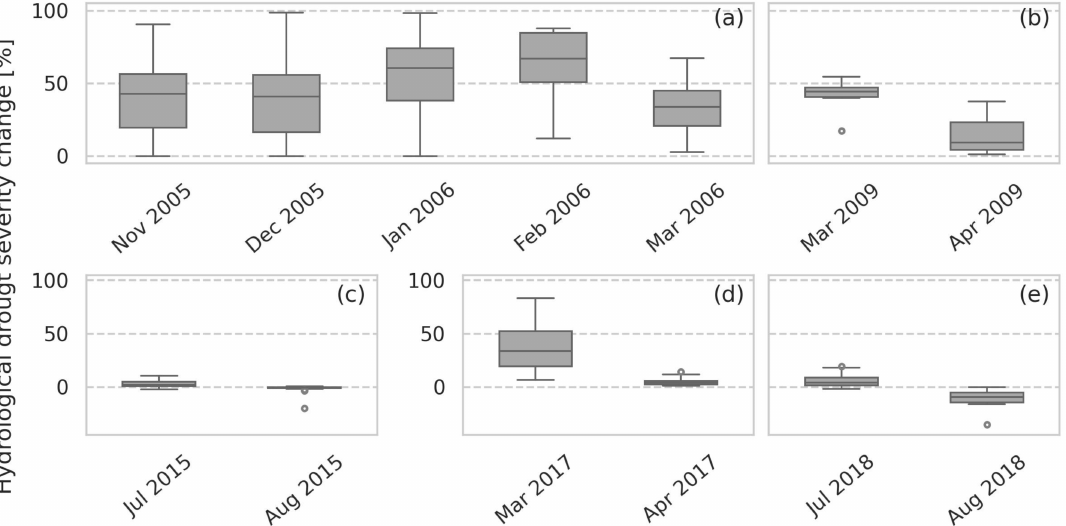
Figure 8. Hydrological drought severity changes in the subbasin where RWH ponds are applied and in subbasins downstream of where they are applied: event I ( a ), event II ( b ), event III ( c ), event IV ( d ), event V ( e ).